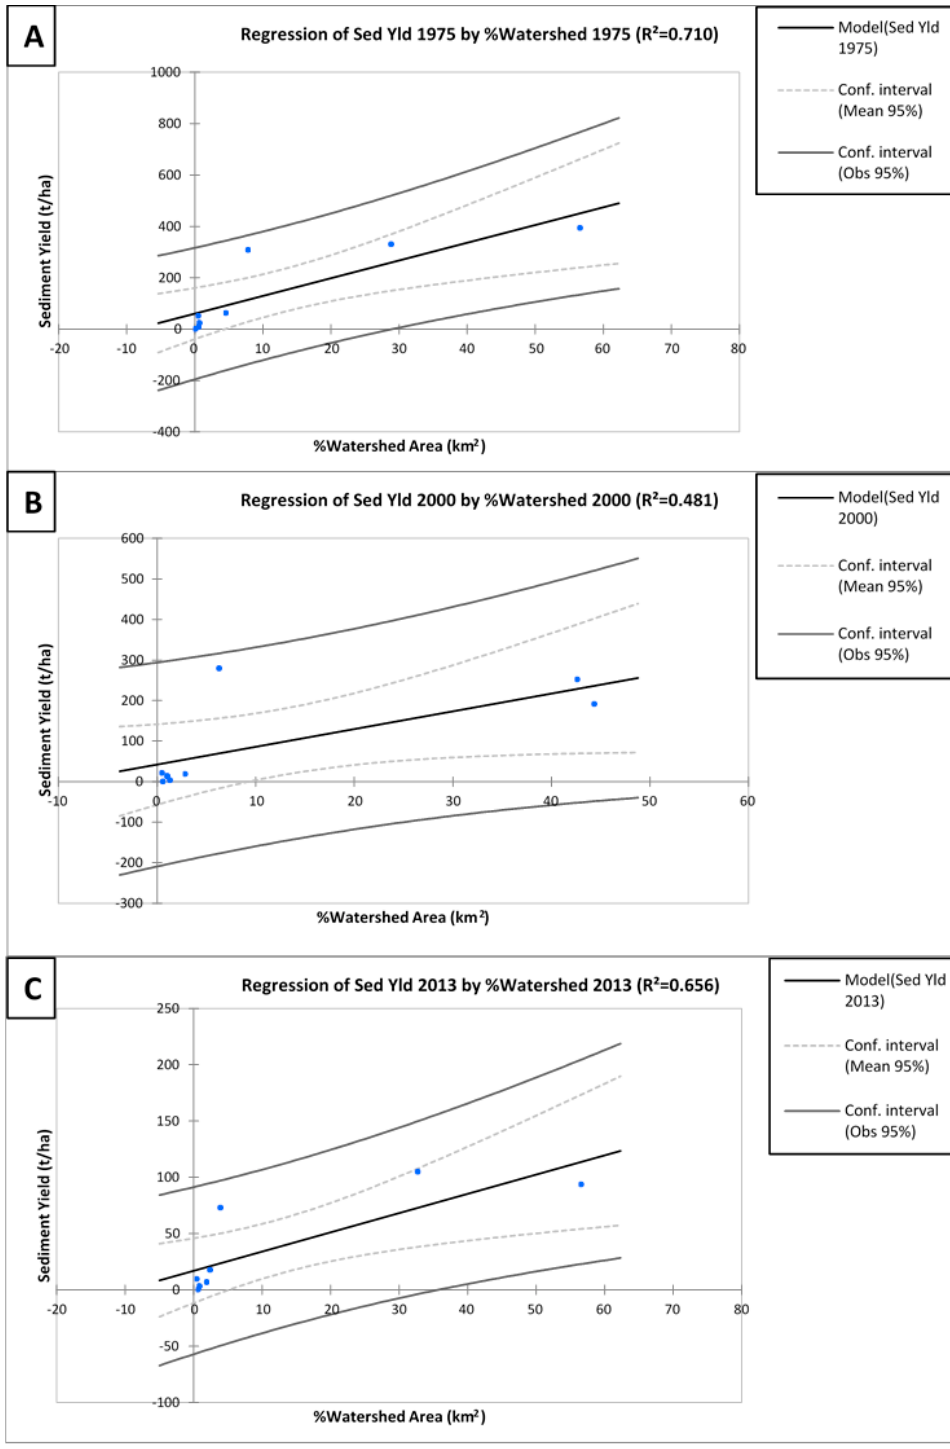
Figure 3. Bivariate relationship between % watershed area and sediment yield. Note the differences in correlation coefficients (R2) in the three years. ( A ), ( B ) and ( C ) represent the scenarios in 1975, 2000 and 2013, respectively.